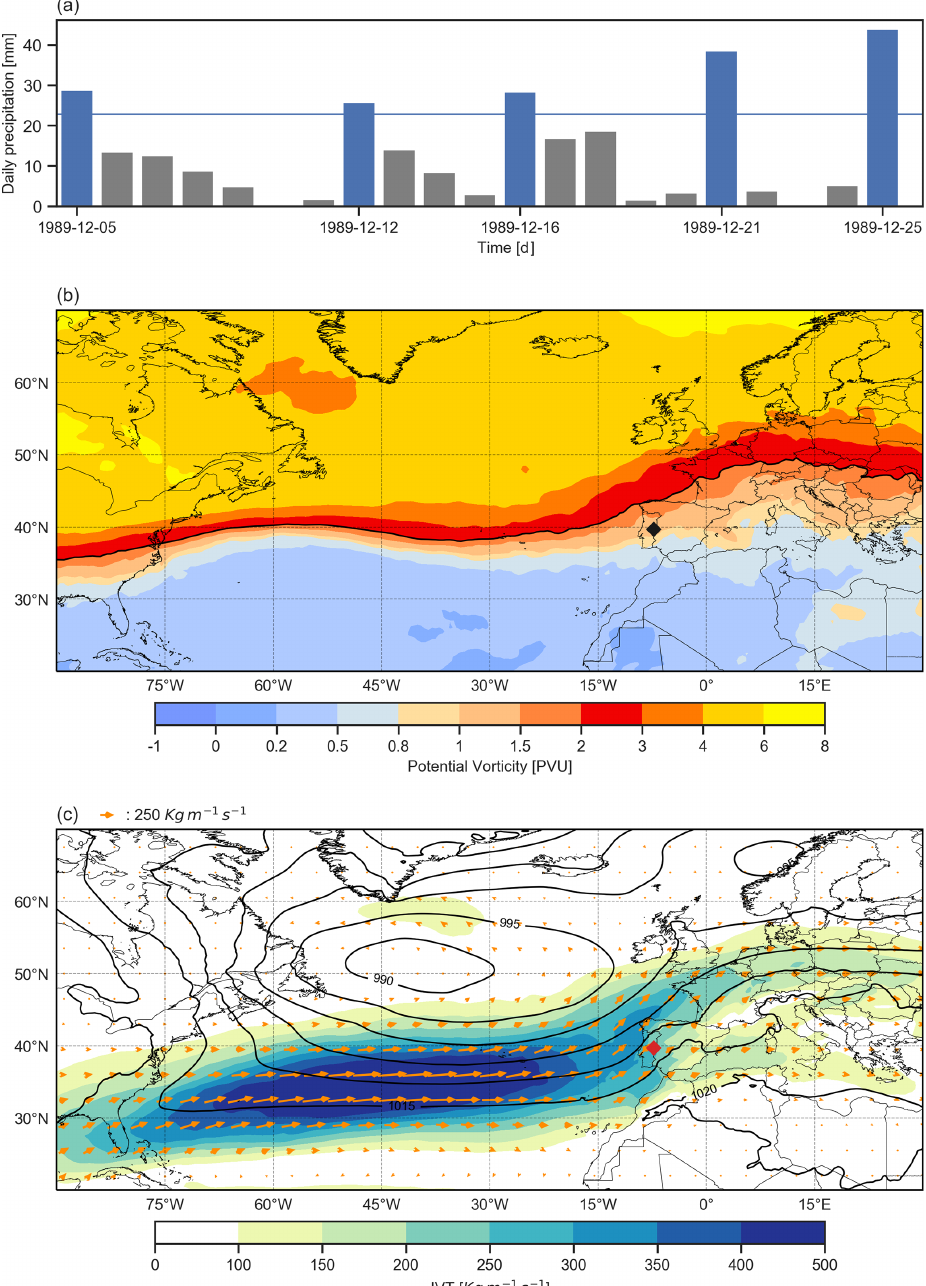
Figure 10. Example of a sub-seasonal clustering episode identified with our procedure for catchment 2060654920 of HydroBASINS. (a) Daily precipitation with extreme precipitation events marked by blue bars. The horizontal blue line represents the 99p of the catch- ment area daily precipitation distribution. (b) Potential vorticity composite in PVU on the 320K isentropic level (colour shading) and dynamical tropopause identified by the 2 PVU contour (black line). (c) Integrated vapour transport composite magnitude (shading) and field in kgm − 1 s − 1 (arrows) and sea level pressure (SLP) composite in hPa (black contours). The black and red markers indicate the catchment location in panels (b) and (c) respectively. Both composites were calculated as the mean of the ERA5 6-hourly fields during the episode.